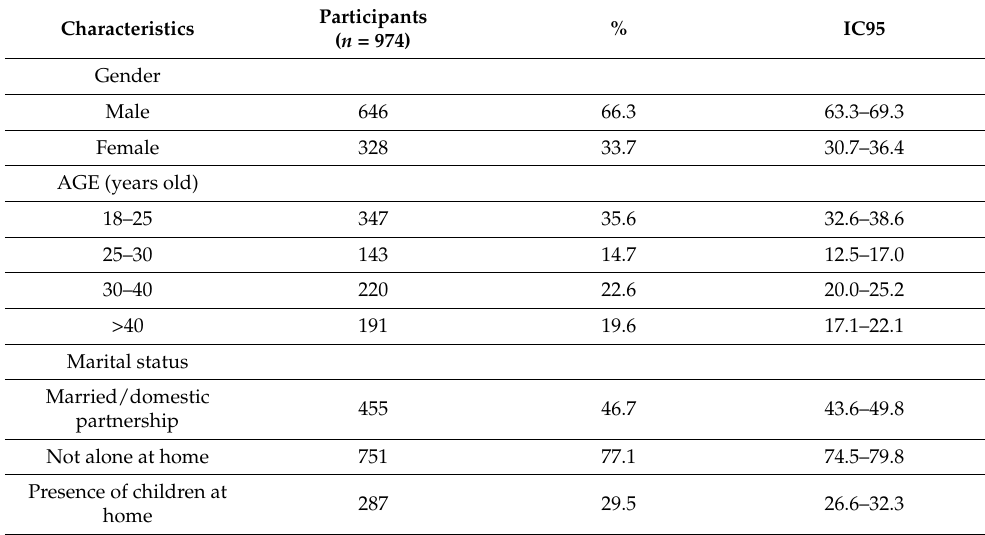
Table 1. Demographics and clinical characteristics of participants reporting alcohol use ( n =